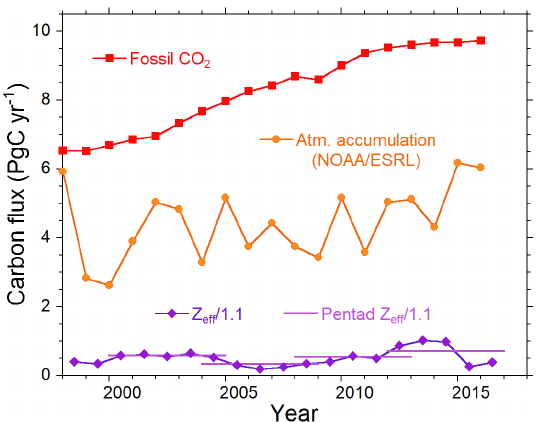
Figure 4. Temporal changes in fossil-fuel CO 2 emissions (red squares), atmospheric CO 2 accumulation rate (orange circles) and ocean outgassing effect Z eff divided by land biotic − O 2 / CO 2 ex- change rate (1.1; purple diamonds). The 5-year averages of Z eff / 1 . 1 used for the pentad (5-year) carbon sink calculations are also de- picted as purple